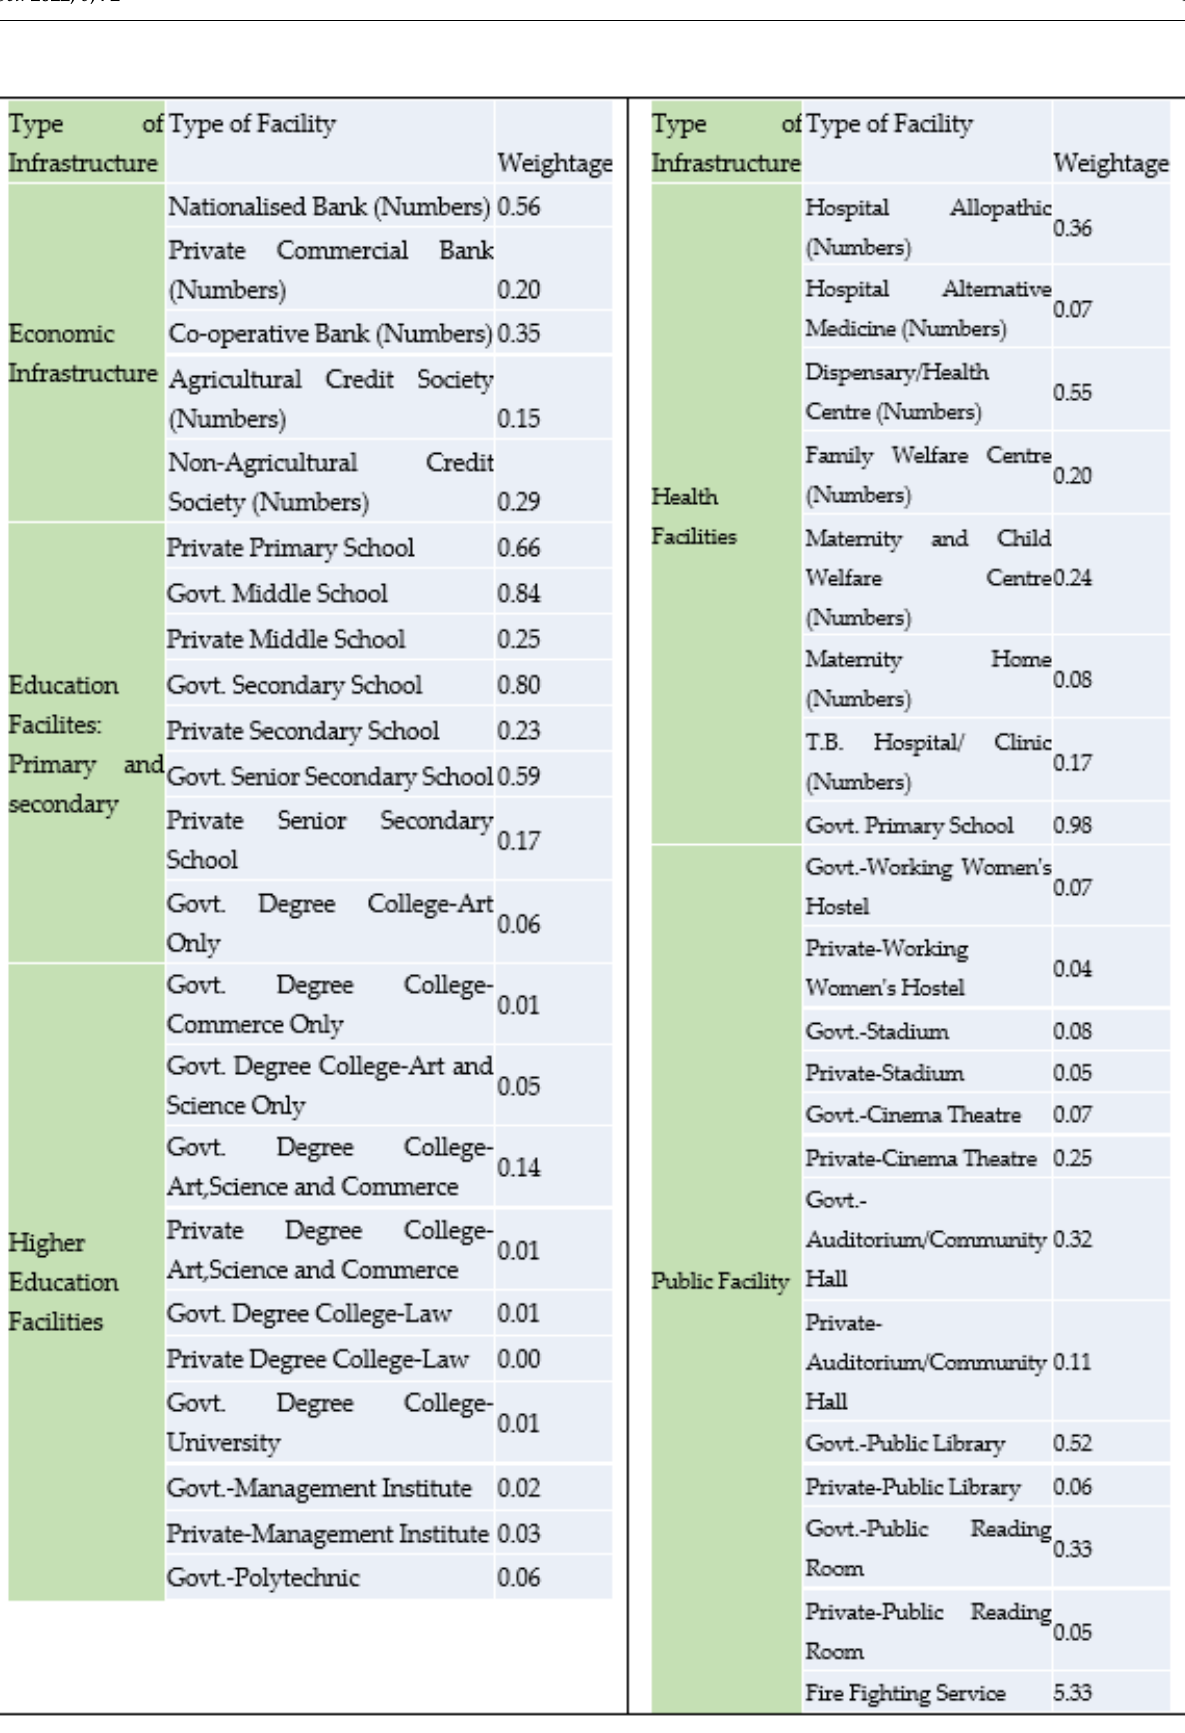
Figure 7. Weightage for each facility in the region.